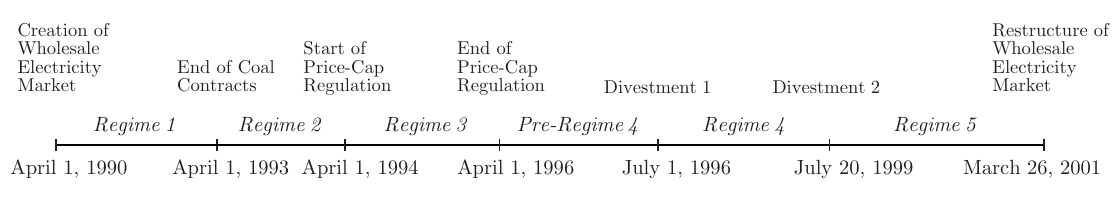
Figure 1. Institutional changes and regulatory reforms during 1990–2001